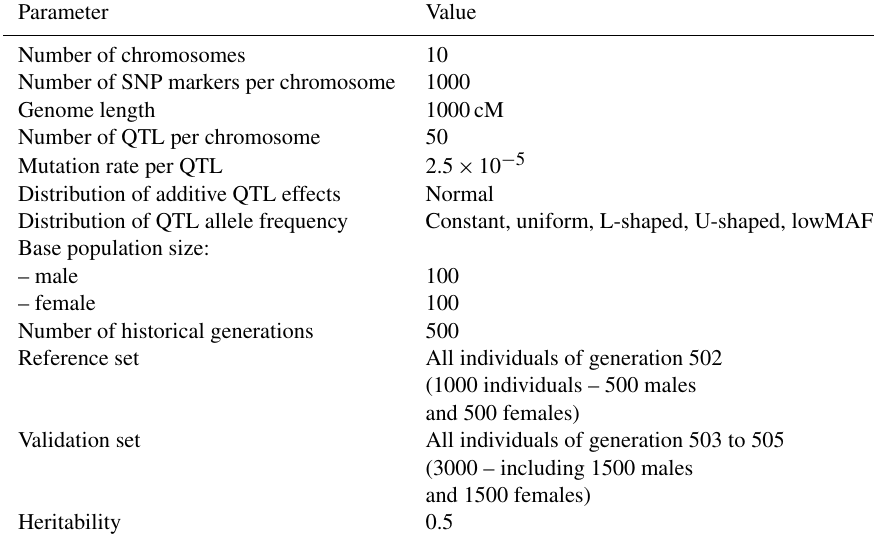
Table 1. Population structure and simulated